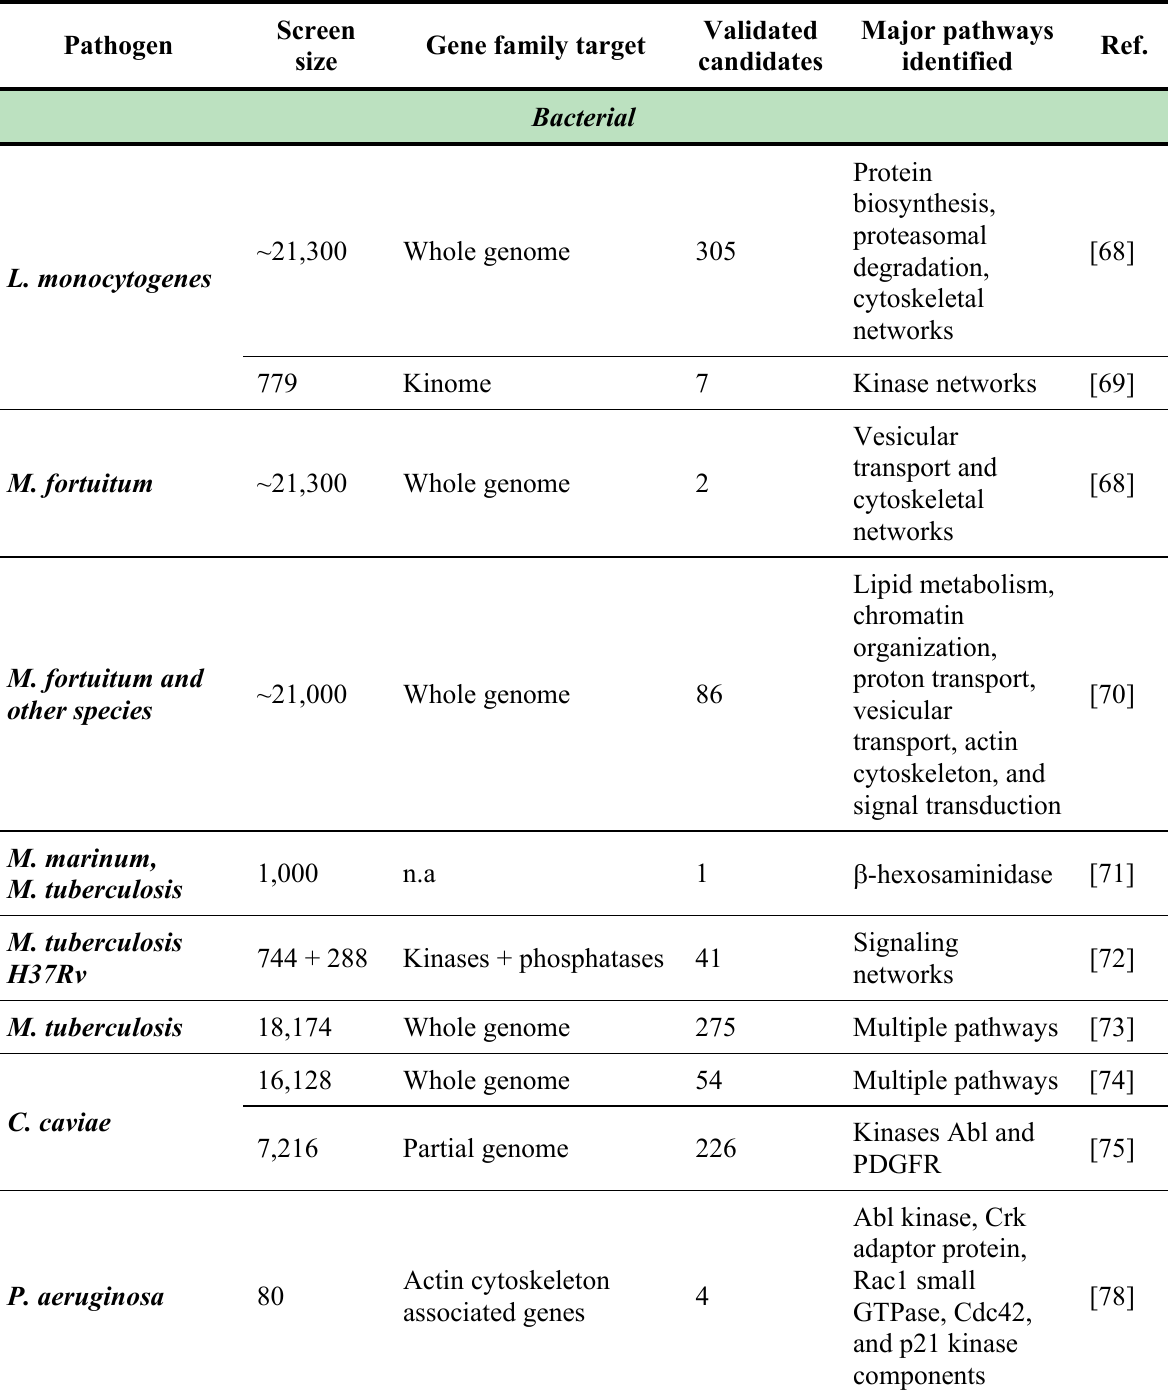
Table 2. Summary of RNAi screens to identify host factors involved in